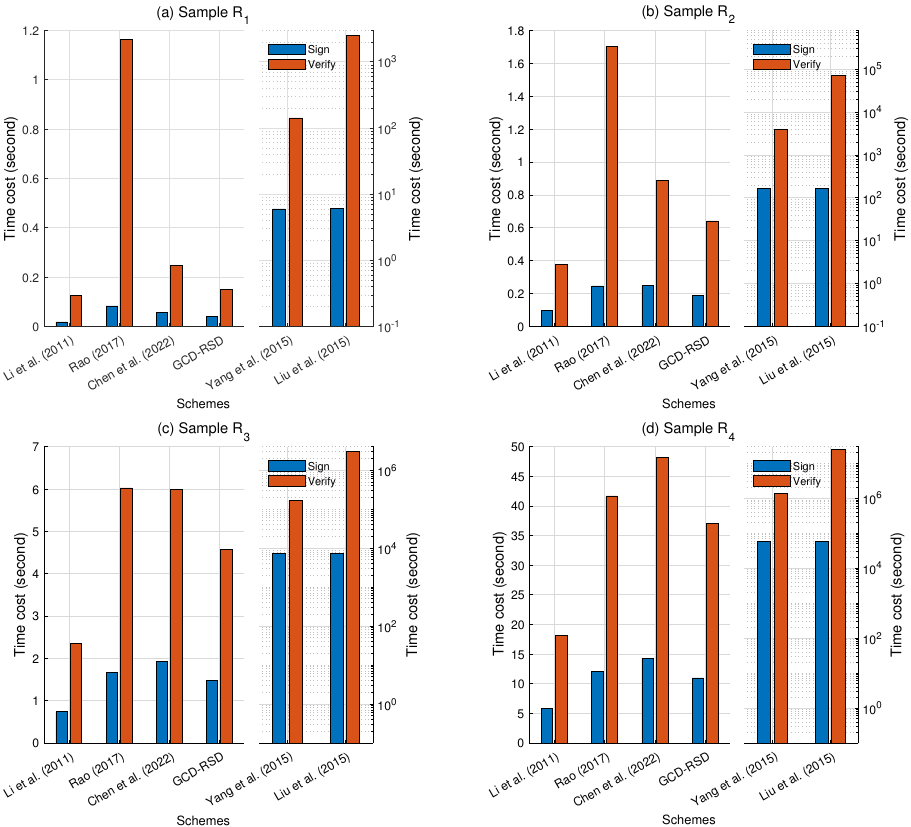
Figure 5. The comparison of the time cost for 6 schemes [15–17,19,28] and GCD-RSD to process R 1 , R 2 , R 3 , and R 4 in terms of Sign (or Signcrypt ) and Verify (or Unsigncrypt